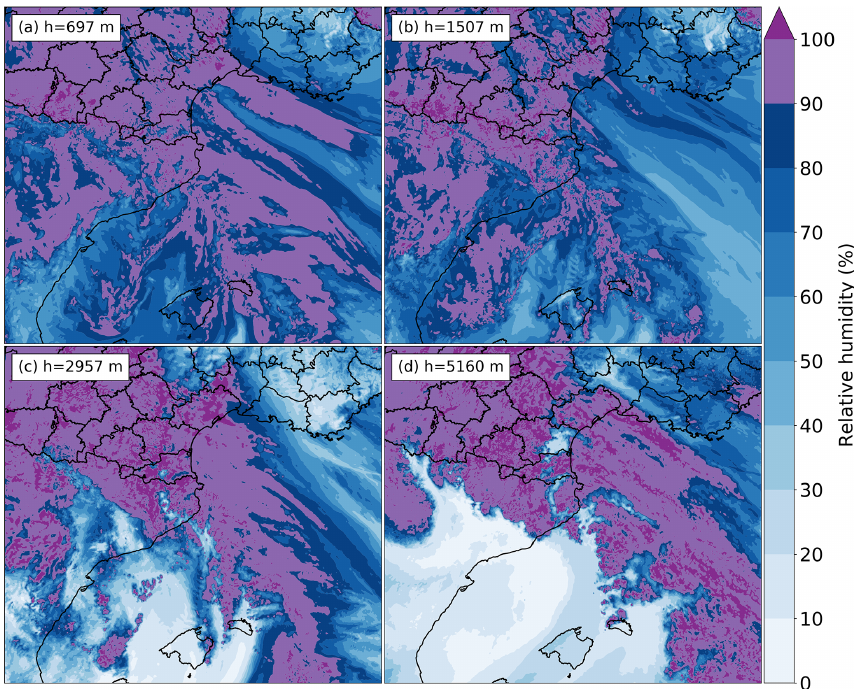
Figure 17. Relative humidity in the REF simulation at 04:00UTC on 15 October at (a) 697m height, (b) 1507m height, (c) 2957m height and (d) 5160m